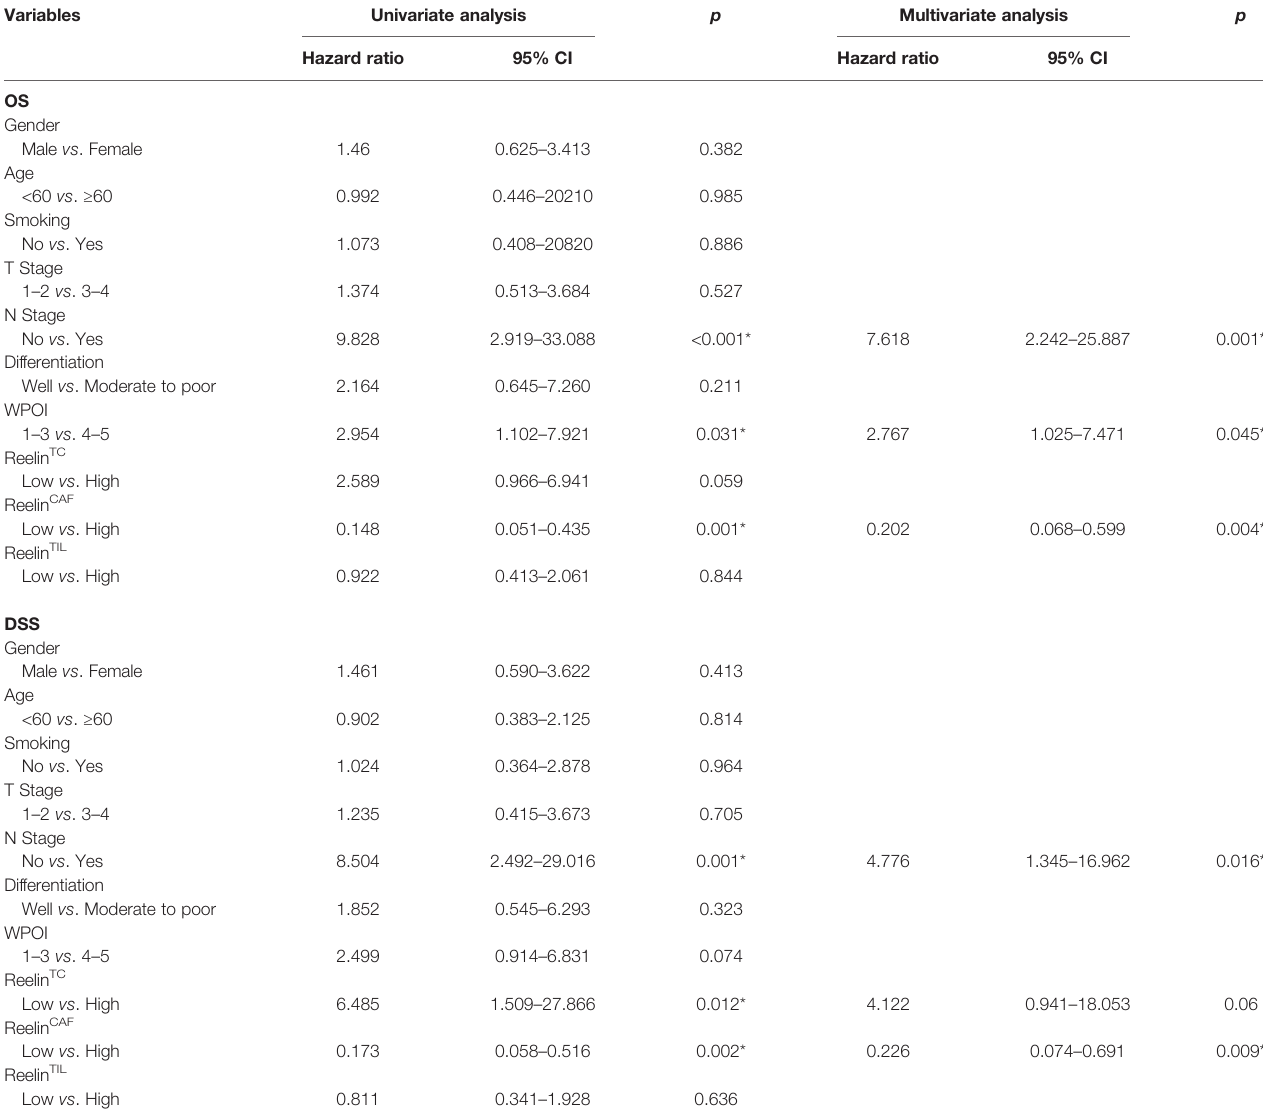
TABLE 2 | Cox-regression analyses of overall survival (OS) and disease-speci fi c survival (DSS) in OSCC